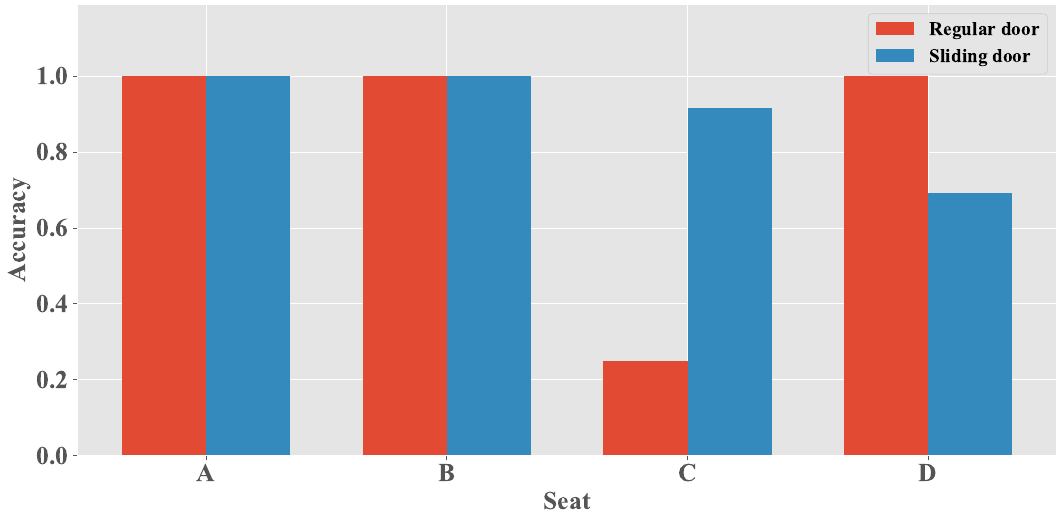
Figure 10. Door detection performance with different type of